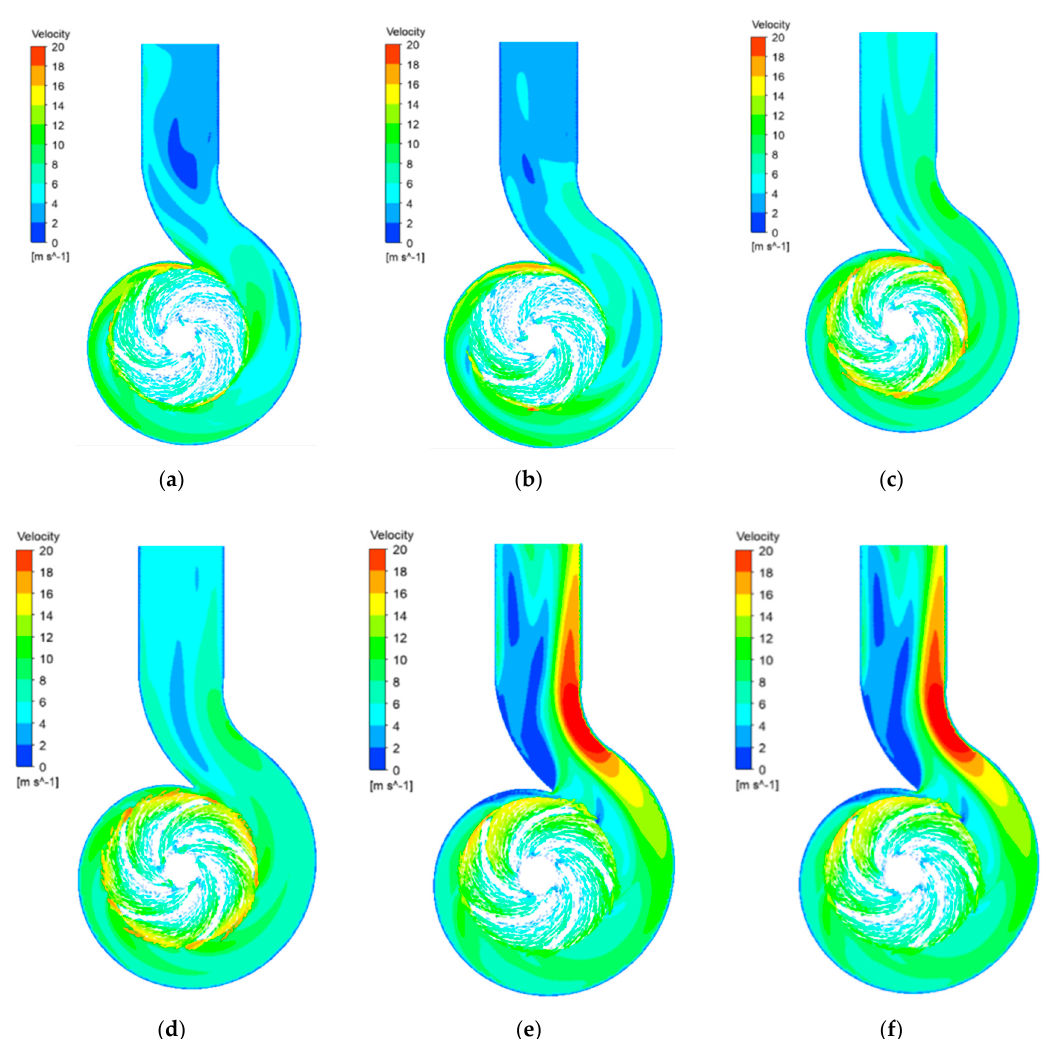
Figure 11. Velocity distributions in volute and vector distribution in impeller midspan of original pump and optimal pump. ( a ) 0.6 Q d (original); ( b ) 0.6 Q d (optimal); ( c ) 0.8 Q d (original); ( d ) 0.8 Q d (optimal); ( e ) 1.0 Q d (original); ( f ) 1.0 Q d (optimal).